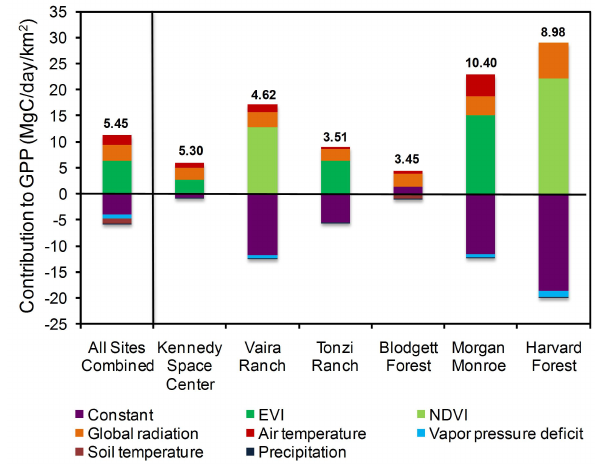
Fig. 2. Total average contribution of each covariate included in the best GR model to GPP estimated at the daily scale for the examined sites. The total contribution is calculated by averaging the portion of GPP predicted from each covariate ( X ˆ β i ) over the entire examined period. Numbers in bold for each site represent the average daily predicted GPP over the examined period (See Table 1 for the length of the annual growing season and the examined time period for each